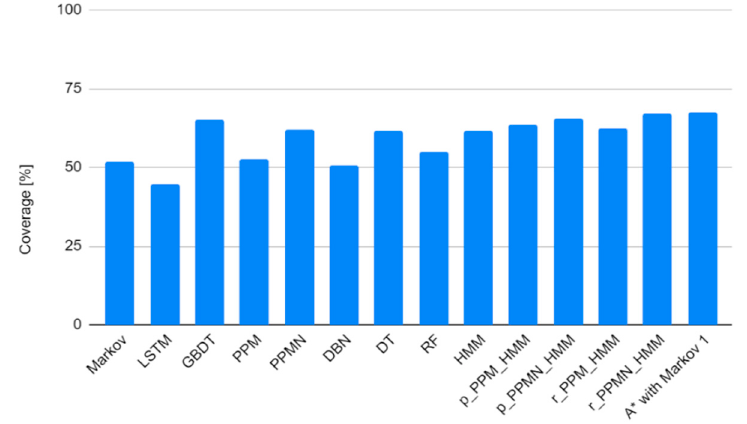
Figure 17. Coverage on the mixed dataset.